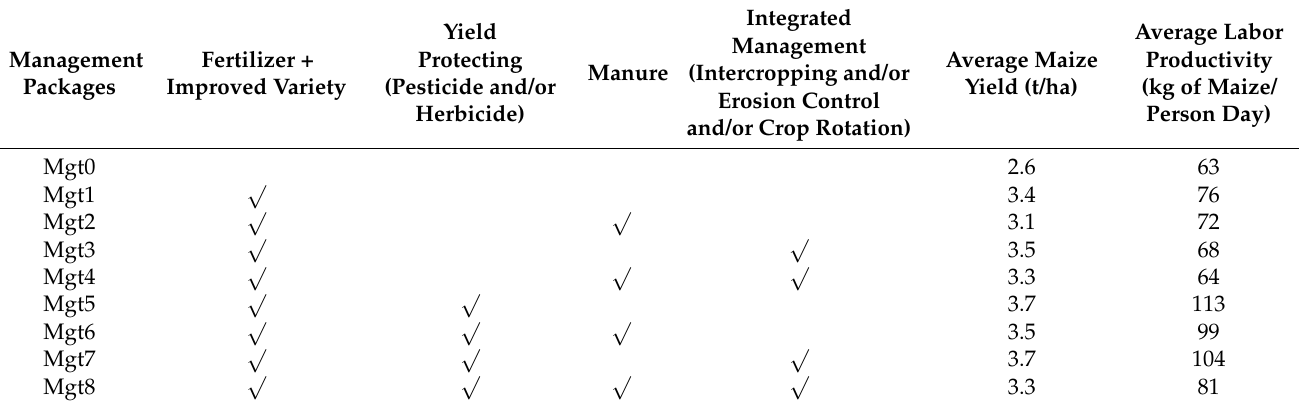
Table 7. Management packages and mean values of outcome